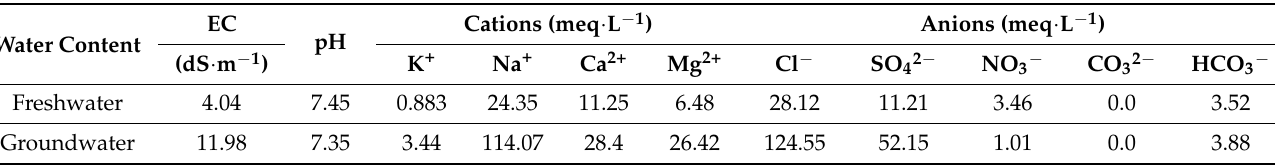
Table 5. Chemical properties of irrigation water